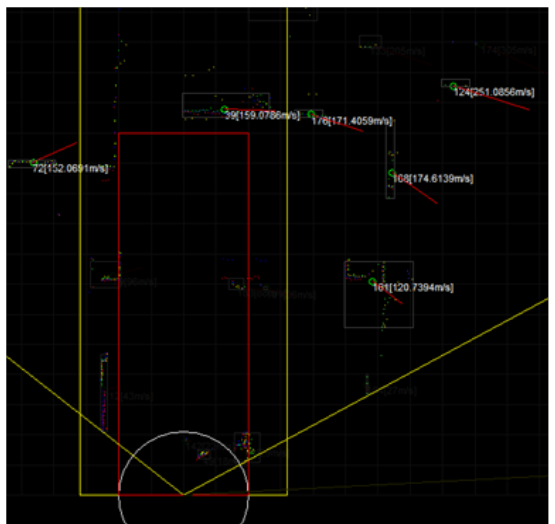
Figure 7. All objects are in the safe zone and there is no collision probability considering heading, velocity, and position of objects.